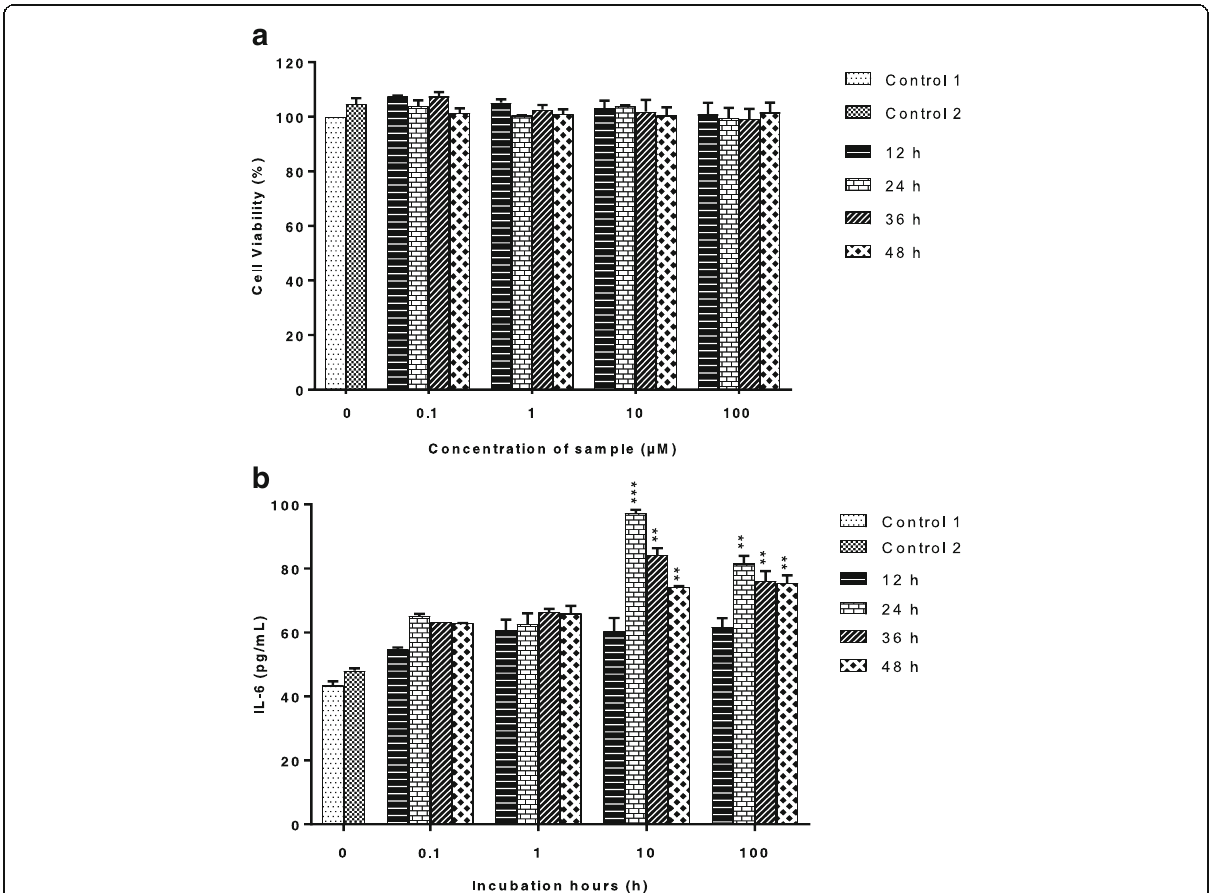
Fig. 1 Effects of histamine on ( a ) cells viability and ( b ) IL-6 production in HaCaT cells. Cells were tested in the presence or absence of histamine. Cells were seeded for 24 h before inducing with different concentrations of histamine (0.1-100 μ M). Cells were then further incubated for 0-48 h. C1; uninduced cells in DMEM only. C2; uninduced cells with 0.1% DMSO was set as negative control. All values are the mean ± S.E.M. of three independent experiments. Values of ** P < 0.01 and *** P < 0.001 were considered significantly different to uninduced control group